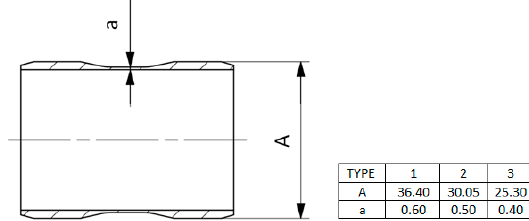
Figure 2. Dimensions of the three types of sleeves produced by AM technology for tests.